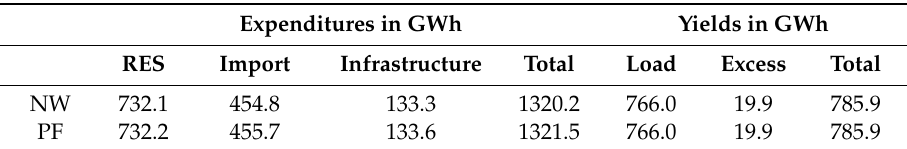
Table 10. CExC expenditures and yields.